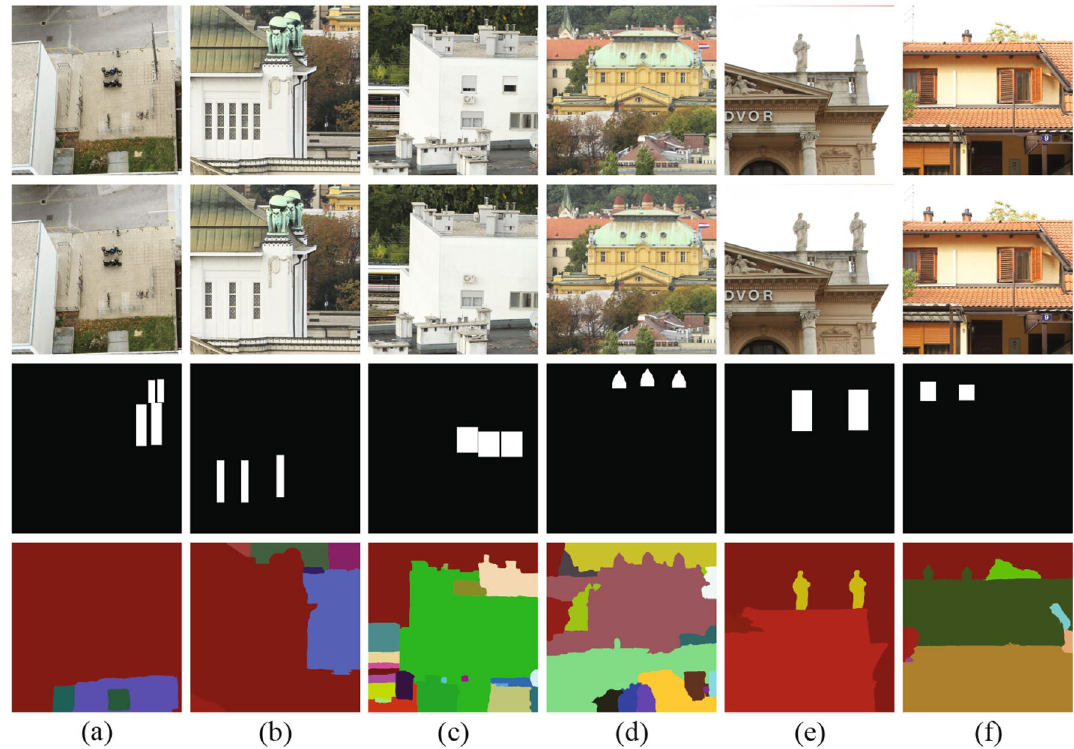
Figure 2. Segmentation results for super-BPD on six images in CoMoFoD 30 datasets. 1st row: original images; 2nd row: forgery images; 3rd row: ground-truth forgery regions; 4th row: segmentation results of the super- BPD. ( a ) 002_F, ( b ) 038_F, ( c ) 030_F, ( d ) 025_F, ( e ) 012_F, and ( f ) 123_F.